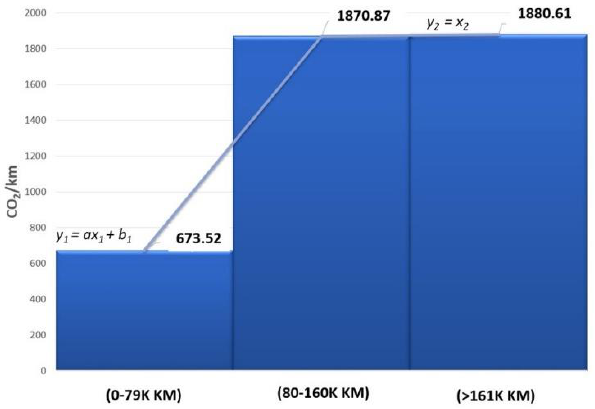
Figure 7. CO 2 emissions trend.